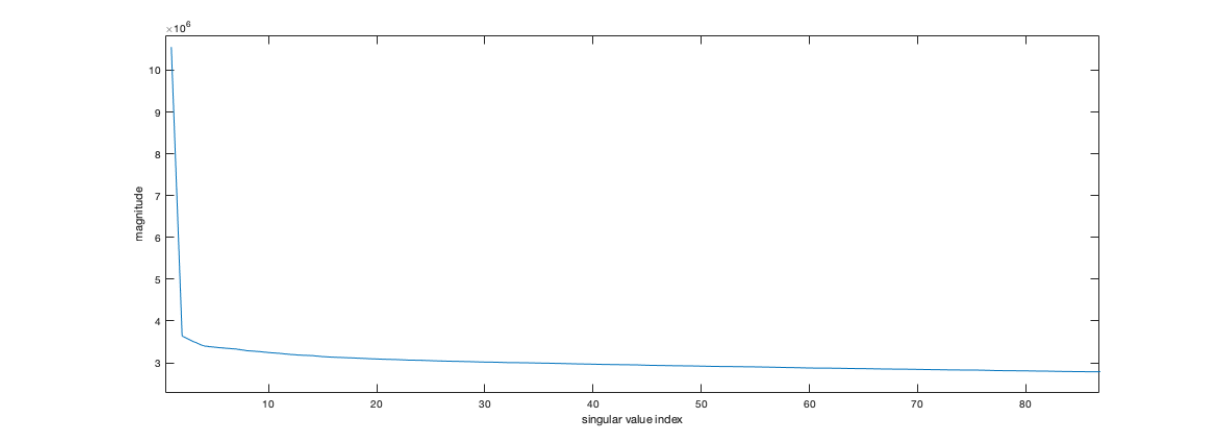
Figure 2. Singular values for the SAR raw data matrix decomposition. On abscissa the indexes of the singular values, on the vertical axis the magnitude. The first singular value is very high compared to the others showing that a large correlation was present in the raw data matrix and exploited in the first left and first right singular vectors.